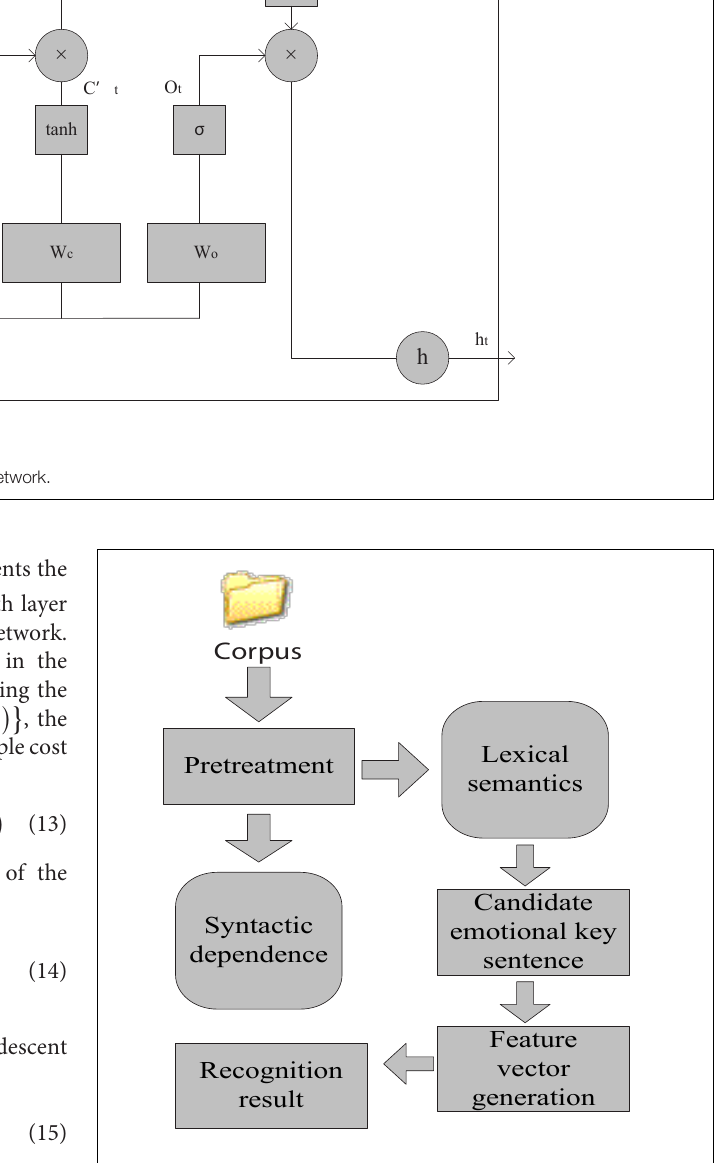
FIGURE 6 | Emotion recognition process based on knowledge